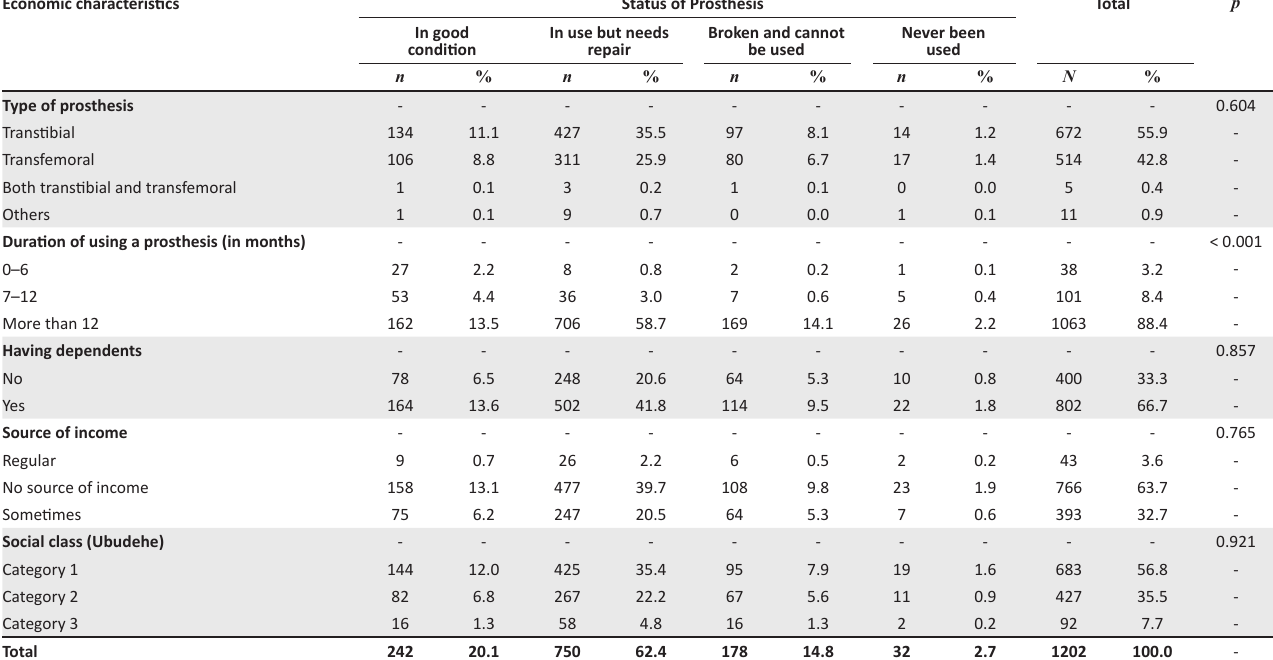
TABLE 3: Status of prosthetic devices of participants.